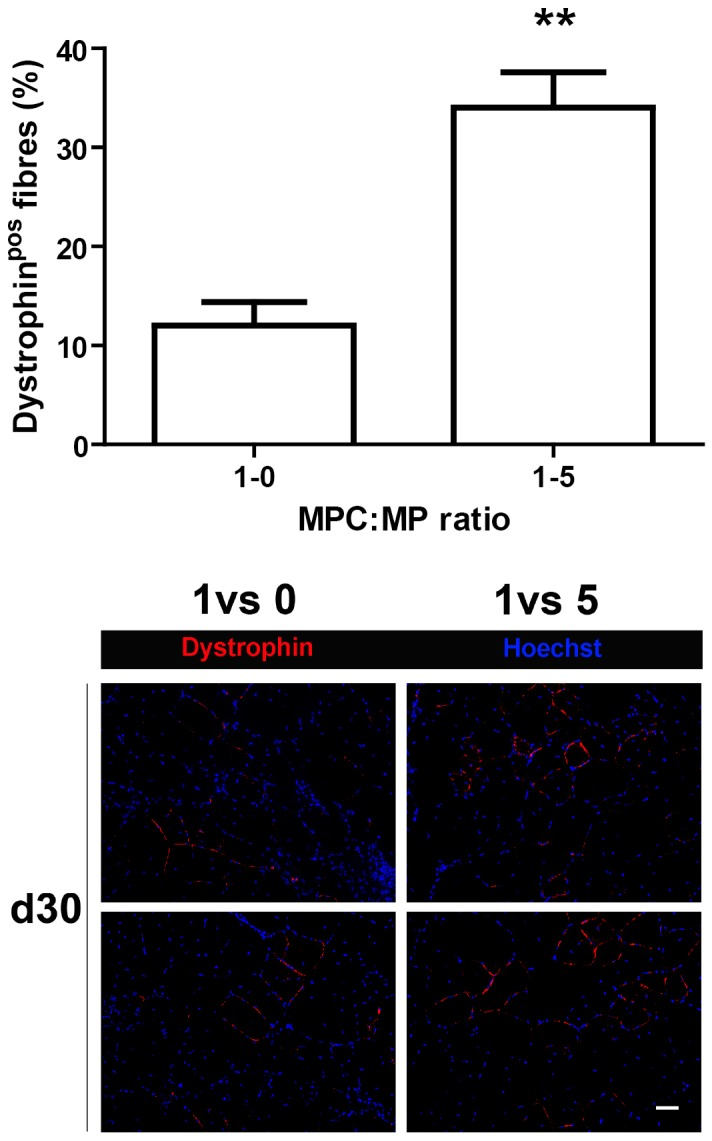
Effect of MPs on MPC participation to regenerating myofibres.GFP-MPCs were injected in mdx TA muscle with or without MPs at 1∶0 and 1∶5 ratios. 30 days after transplantation, muscle sections were analyzed for the expression of dystrophin. The number of dystrophin positive myofibres is given for one field and represents mean ± sem of 3 independent experiments). ** = P<0.01. Representative micrographs show dystrophin positive myofibres in the 1∶0 and 1∶5 conditions (two examples per condition). Bar = 10 µm.